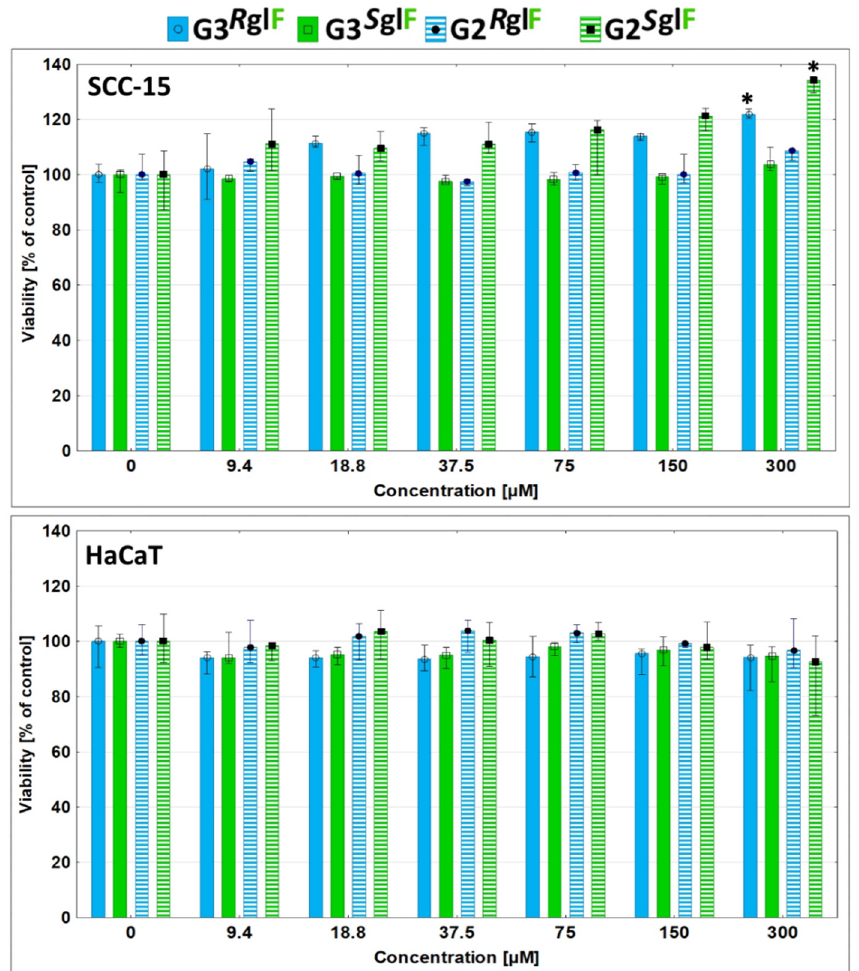
Figure 5. Cytotoxicity of G3 R glF , G3 S glF , G2 R glF , and G2 S glF after 24 h treatment of human squamous carcinoma cells (SCC-15) and human immortalized keratinocytes (HaCaT). Cell viability is presented as medians of a percent against non-treated control (control expressed as 100%). The whiskers are lower (25%) and upper (75%) quartile ranges. * p ≤ 0.05; Kruskal–Wallis test (against non-treated control).